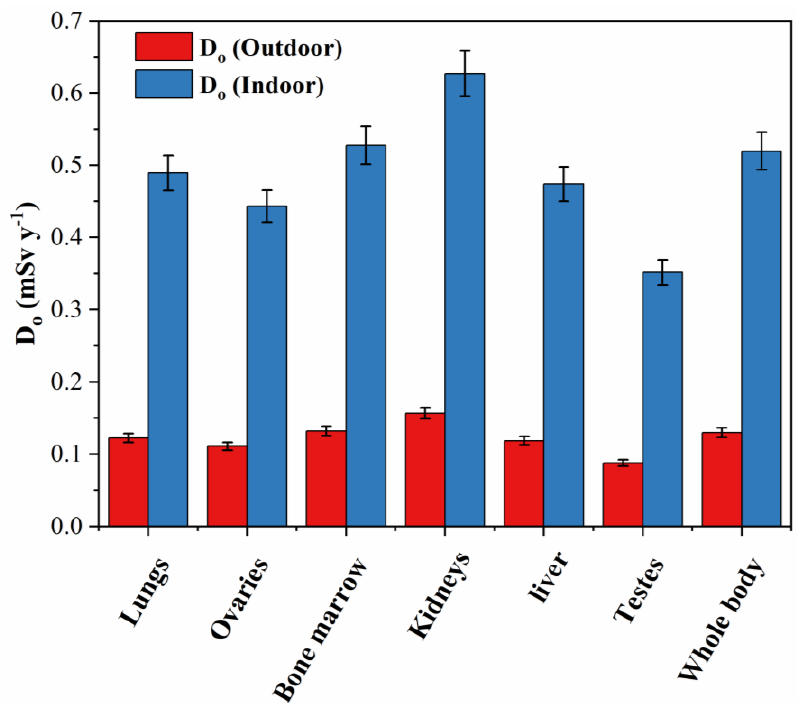
Figure 9. The D o (mSv y − 1 ) associated with tissues from outdoor and indoor air doses of the monzogranites.